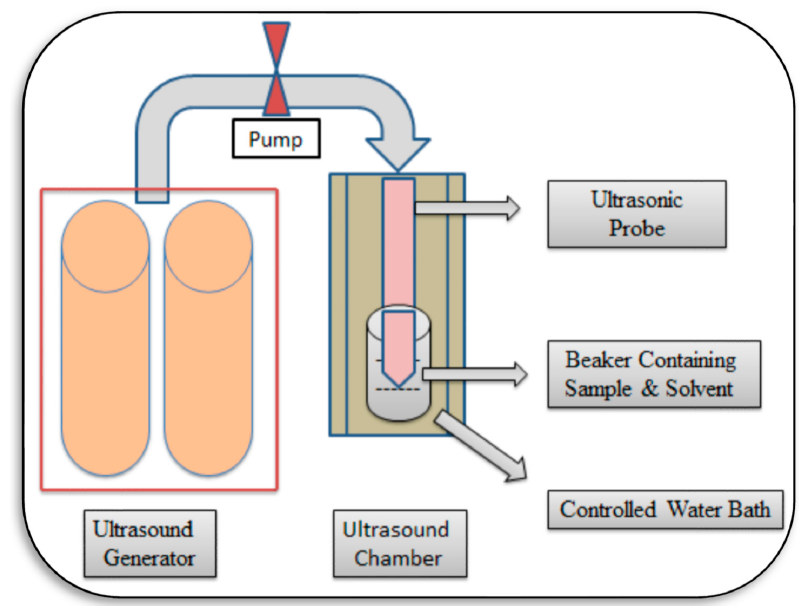
Figure 4. Ultrasonic assisted extraction .